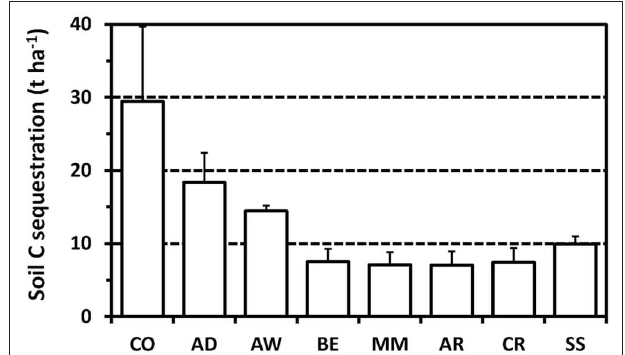
FIGURE 8 | Uncertainty in soil C sequestration for different EOM type added to the S. Martino soil at a rate of 1t C ha y − 1 for the period 2001–2100. CO, compost; BE, bioenergy by-products; AD, anaerobic digestates; MBM, meat and bone meals; AR, animal residues; CR, crop residues; AW, agro-industrial wastes; SW, sewage sludges. Error bars represent standard deviation of the different estimates of C sequestration using the range of pool parameters derived from the optimization procedure.